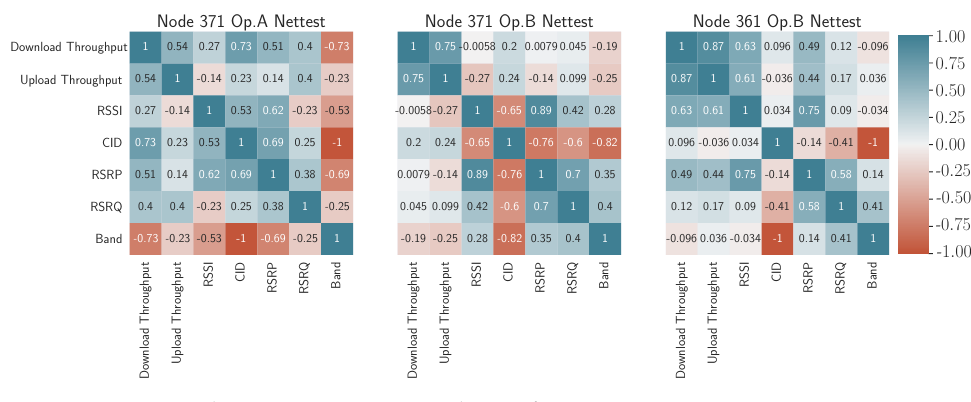
Figure 12. MODEM log parameter–KQI correlations for